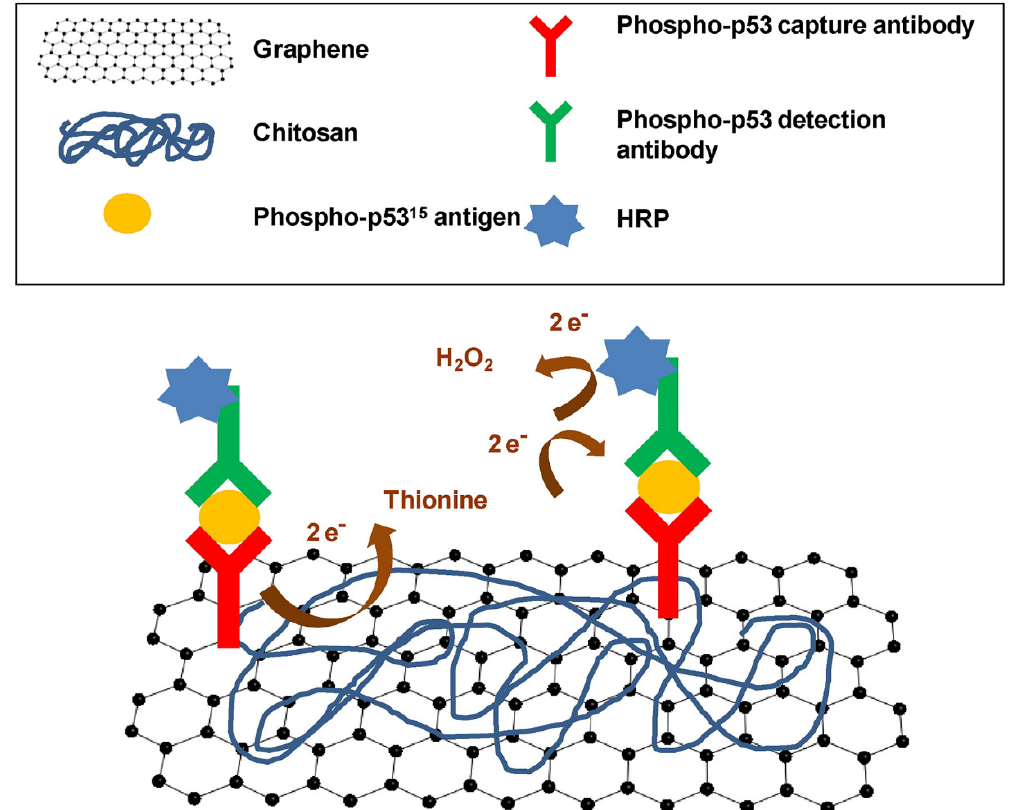
Figure 11. Schematic representation of sensitive nanocomposite based on graphene and chitosan- modified screen-printed carbon electrode (SPCE). Reproduced with permission from Orecchioni et al., Adv. Drug Deliv. Rev.; published by Elsevier, 2016 [193].